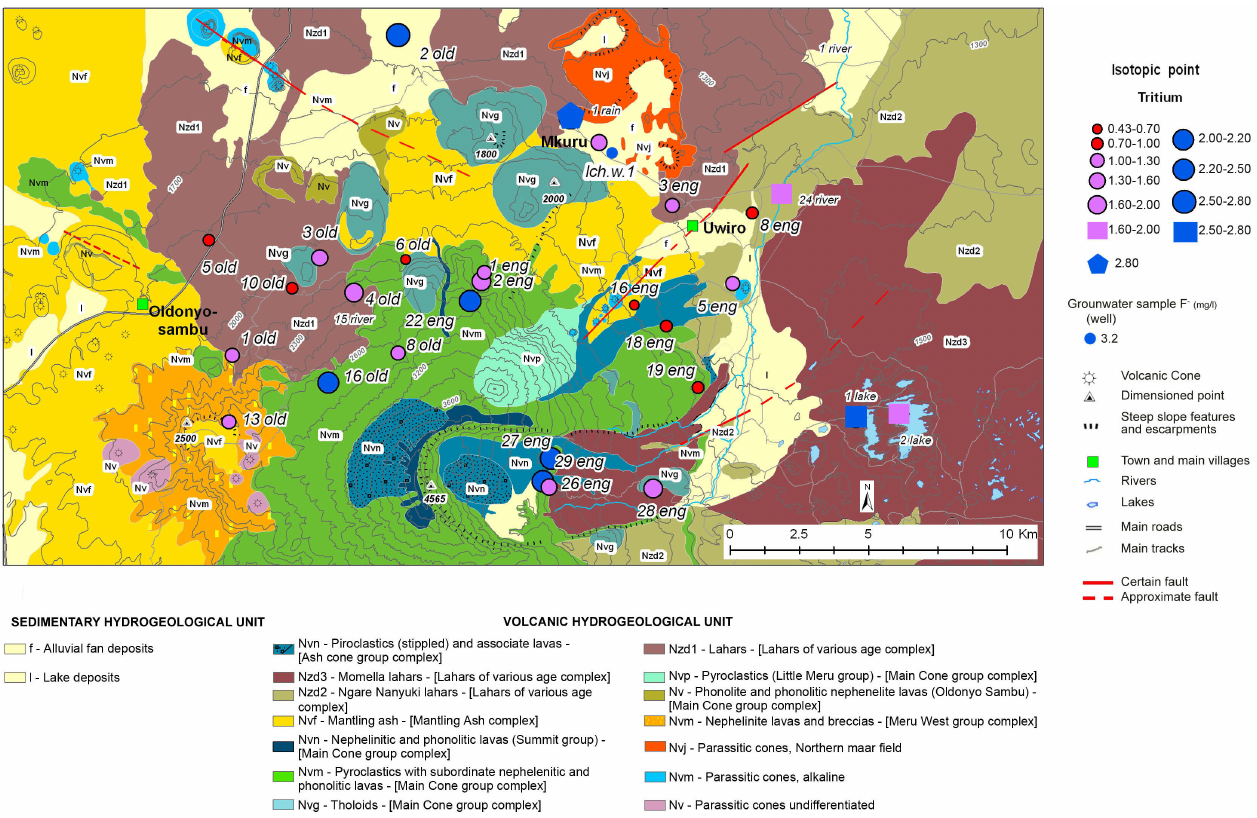
Fig. 9. Distribution map of the study area, indicating the location of isotopic water points classified according to their 3 H content.